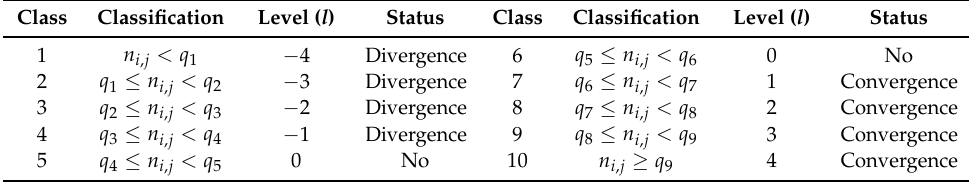
Table 2. Classification and labeling rules for n i, j , where q 1 , q 2 ,…, q 9 represent the netflow values of nine break points in quantiles 10%, 20%, …, and 90%, respectively.